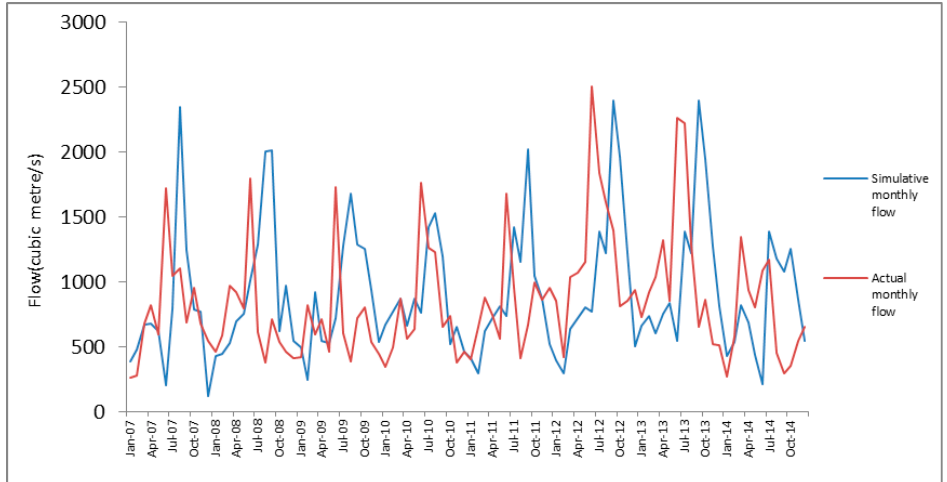
Figure 5. Monthly discharge from Xiaolangdi reservoir.